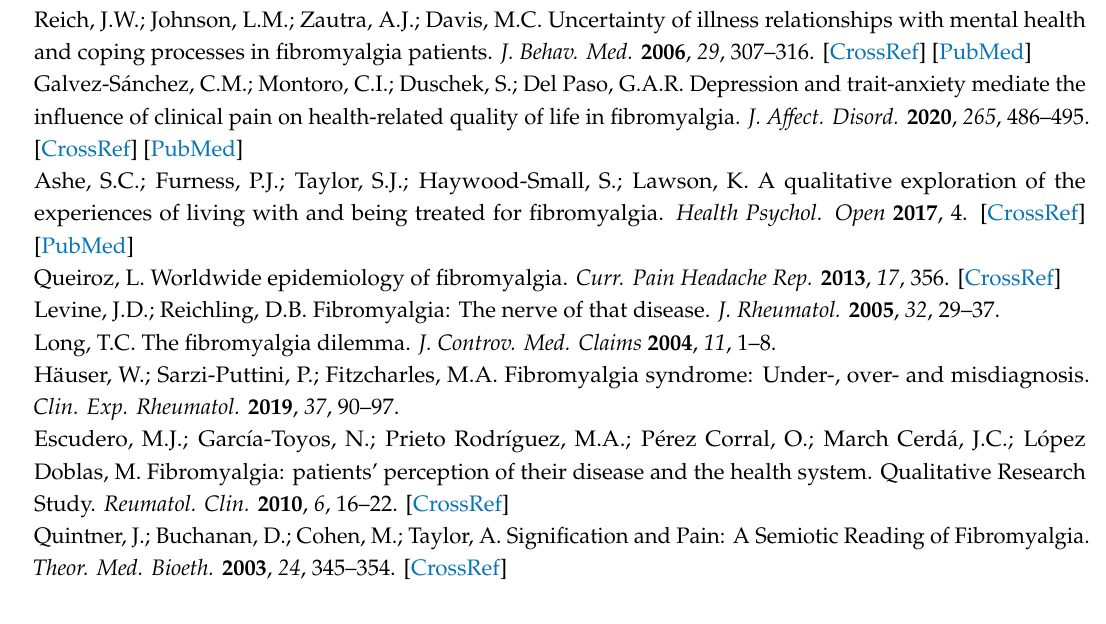
Table S1: Results after a methodological evaluation using CASPe. Table S2: Analysis of the studies included in the review with the most relevant results for each. Table S3. Categories and subcategories of Mishel’s model of Uncertainty in Fibromyalgia Syndrome, identified in the experiences of patients from di ff erent qualitative studies. Author Contributions: Conceptualization, A.F.-A. and C.T.-O.; methodology, A.F.-A.; software, C.T.-O.;